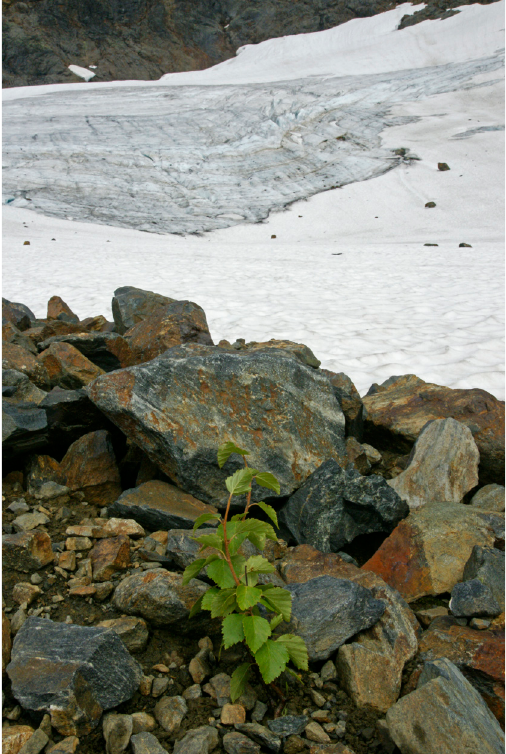
Figure 11: Young birch sapling, which has established at the top of a frontal moraine close to the lower margin of the glacier Ekorrglaciären, 1370 m a.s.l. This site is about 500 m higher than the local treeline. 5 September 2003.